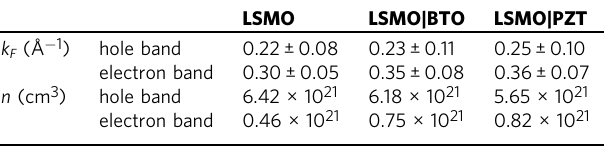
Experimental Fermi wavevectors k F extracted from the momentum distribution curves (MDCs) at the Fermi energy (E F ) for the bands de fi ning the hole and electron pockets, and the corresponding hole and electron densities, n, for La 0.7 Sr 0.3 MnO 3 (LSMO) surface in comparison with the interfaces with ferroelectrics (FE = PbZr 0.2 Ti 0.8 O 3 – PZT and BaTiO 3 - BTO), LSMO|FE. The errors express the standard deviation and are extracted from the fi t of the MDCs with a combination of Lorenz distribution and smooth